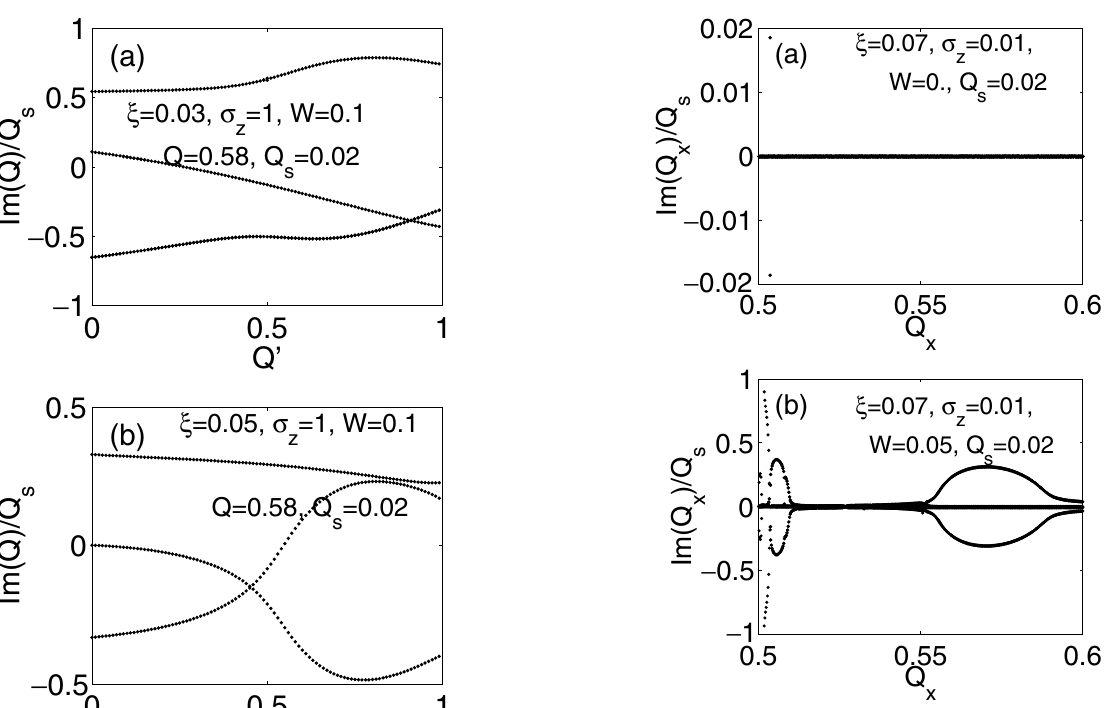
FIG. 4. Dependence on the horizontal tune. (a) W (cid:4) 0 ; (b) W (cid:4) 0 : 05 . Note that the W (cid:4) 0 case has an expanded vertical